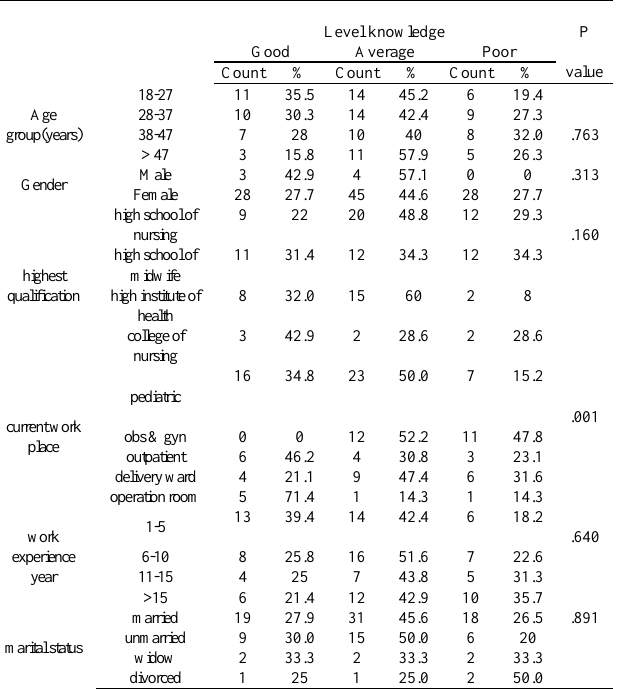
Table 3: the association of knowledge score to some sociodemographic characteristics Level knowledge